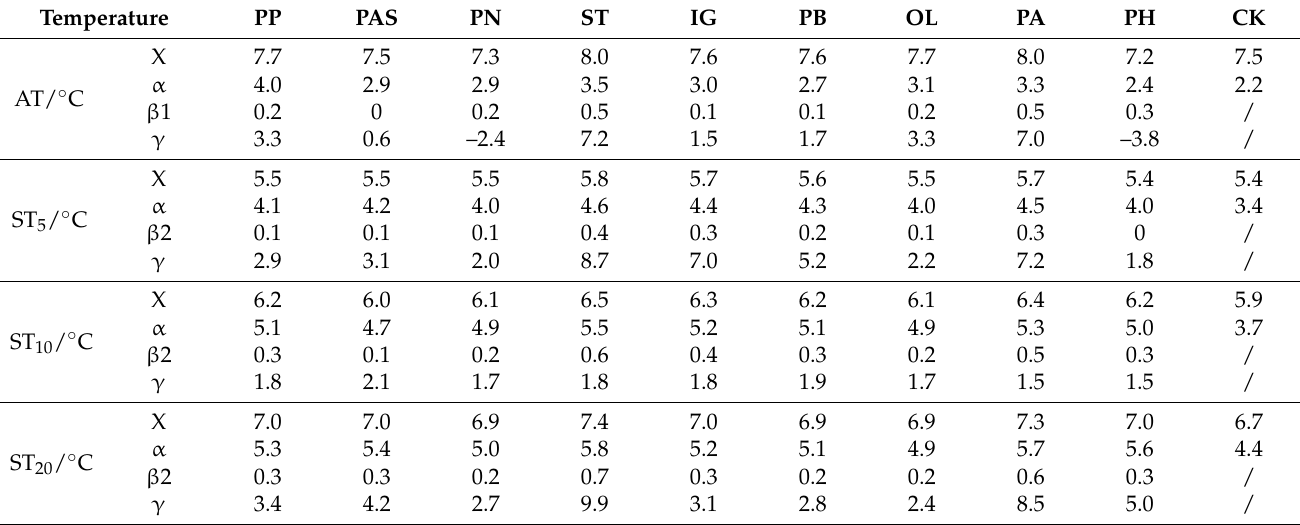
Table 3. Comparison of AT and ST in the different communities in